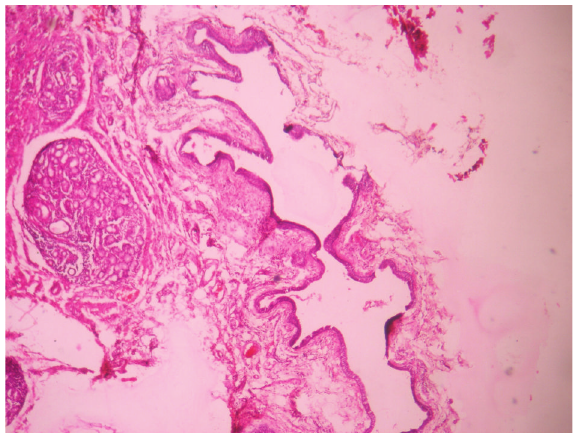
Figure 4: Mucous salivary gland with extralobular dilated tortuous ducts at 40x.